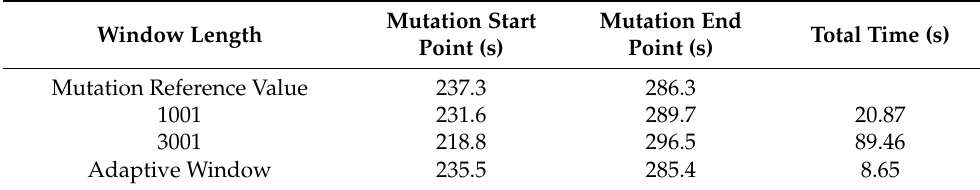
Table 2. Mutation Point and Total Time Comparison Table.